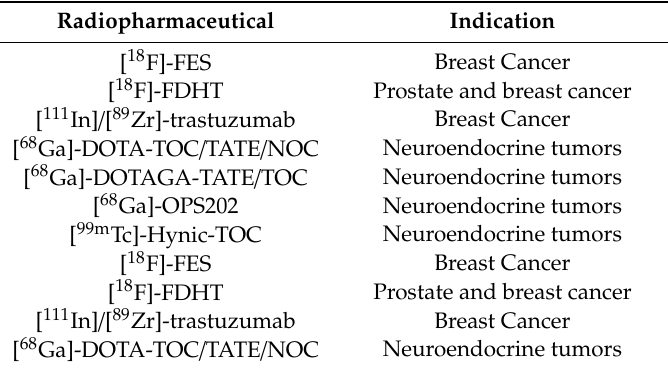
Table 1. Overview of discussed